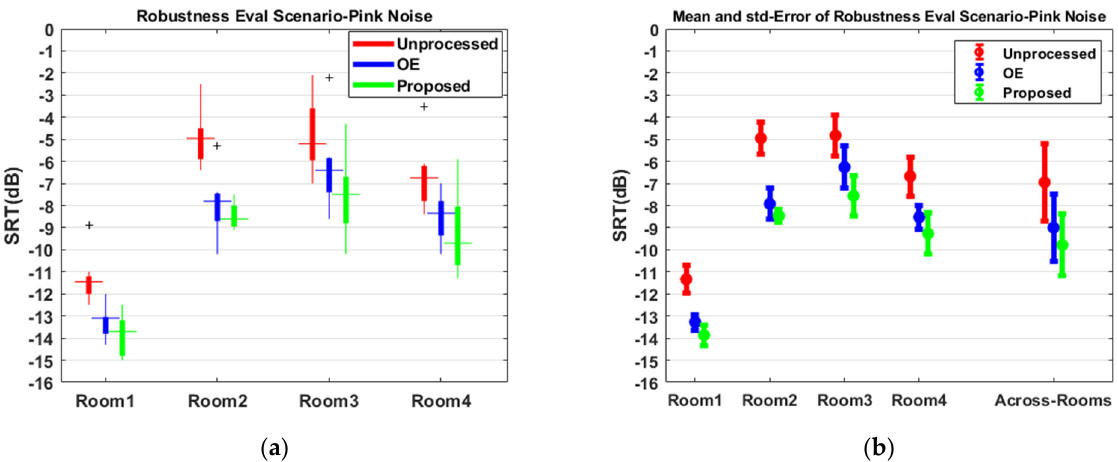
Figure 11. ( a ) Boxplots of speech reception thresholds at SRT 50 for 8 subjects to evaluate the robustness of preprocessing methods in the presence of pink noise (PN) are illustrated. The unprocessed and the preprocessed signals for the main scenarios using the OE and proposed method are compared.; ( b ) The mean-SRT 50 and the standard errors for the same data in ( a ) are plotted.